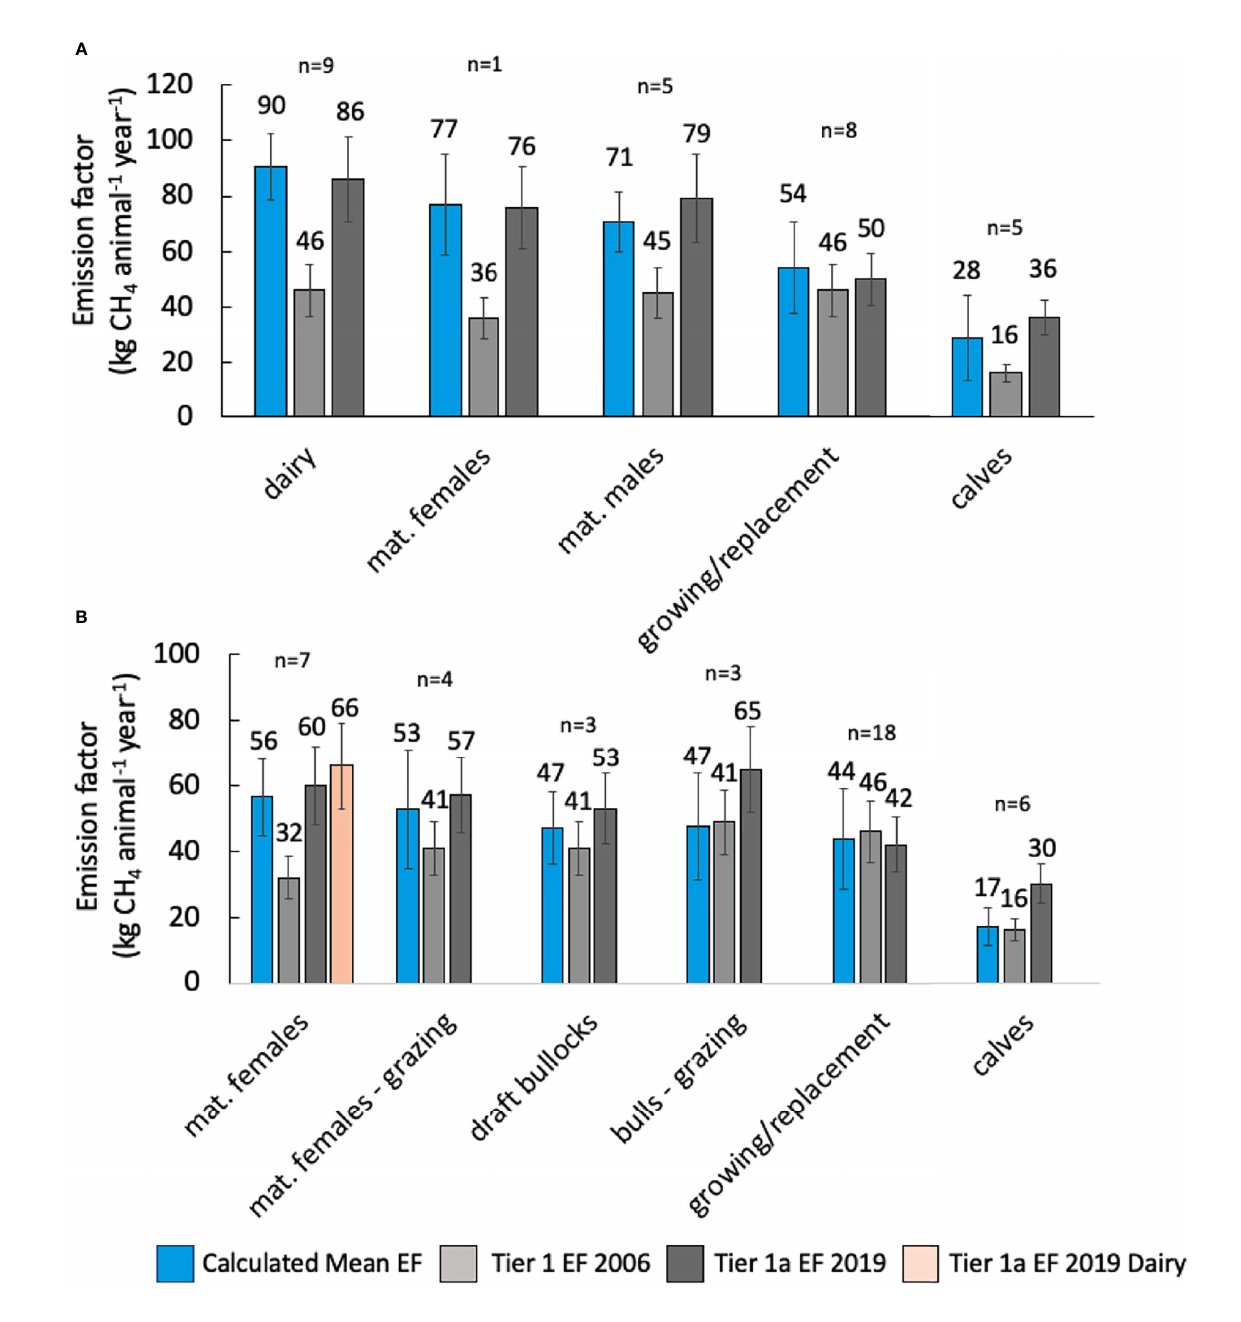
FIGURE 2 | Mean of enteric CH 4 emission factors (EFs) for cattle in sub-Saharan Africa by class and compared to 54 Tier 1 and IPCC 2019 Tier 1a defaults. Error bars for calculated mean EFs are expressed as ± 95% CI, whereas errors bars for IPCC default EFs express default uncertainty as a percent (50%). Panel (A) shows high productivity cattle systems, panel (B) shows low productivity cattle systems. Mat. Females/males stand for mature females/males. n = number of individual observations for each